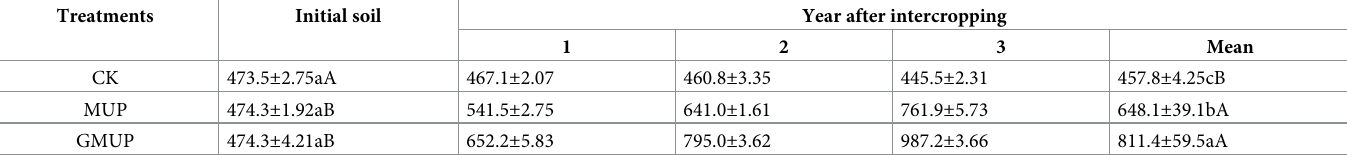
Table 2. Total hydrolyzable nitrogen fractions content of different treatments in the initial soil and the soil after three intercropping years (mg � kg -1 ). Treatments